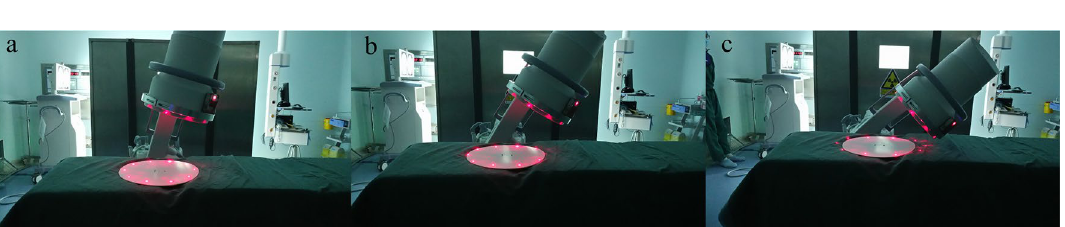
Figure 10. Three shooting distances ( X ) in the experimental group. ( a ) X = 10 cm. ( b ) X = 30 cm. ( c ) X = 50 cm.